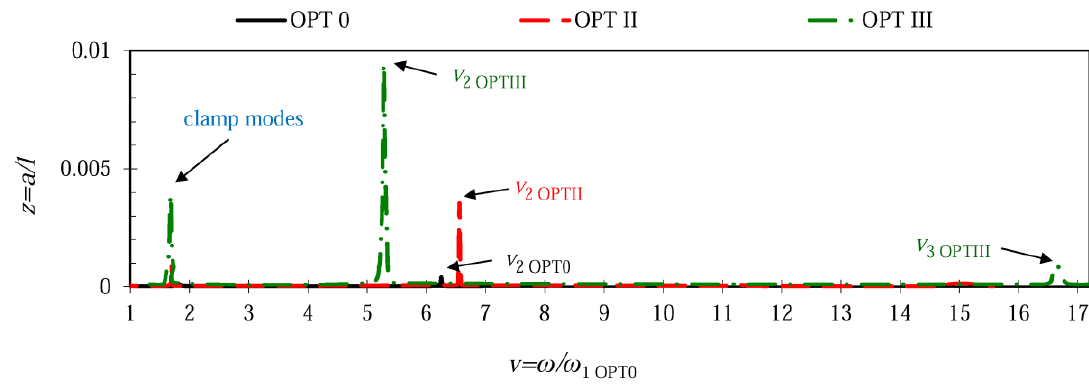
Figure 7. Frequency responses of different microcantilever configurations when the rigid stopper is located at x / l = 0.78 ≈ 0.8.